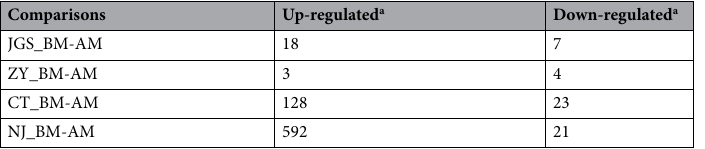
marily during the last larval instar in spongy moth, a Northern blot study detected relatively small steady-state quantities of vitellogenin RNA in adults, suggesting that completion of oogenesis initiated during the larval and pupal stages may require some small degree of vitellogenin synthesis early during the adult stage 45 . It is gener- ally accepted that female spongy moths produce 500–1000 eggs, but there are no data indicating a consistently significant difference in egg production between ASM and ESM. There has been no formal study on the appli- cability of flight-oogenesis syndrome to ASM females, but some recent research suggests that there is not always an obvious trade-off between insect migratory flight and reproduction 46 . NADH dehydrogenase subunit 1 (TRINITY_DN57574_c0_g1, TRINITY_DN50963_c0_g2), NADH dehydrogenase subunit 4 (TRINITY_DN42442_c0_g1). NADH dehydrogenase is involved in aerobic respiration and ATP synthesis 47 . Solitary locusts have higher initial flight speeds and shorter flight dis- tances than gregarious locusts, and exhibited higher mitochondrial energetic storage (Acetyl-CoA and NADH), energy metabolic gene-expression levels, and metabolic enzyme activities in their flight muscles than their gre- garious counterparts 48 . While NADH dehydrogenase subunit DEGs (for subunits 1 and 4) were found to be down-regulated in ASM, one DEG with matches to different NADH dehydrogenase subunit 1 sequences were up-regulated in ASM, suggesting either sequence divergence at this locus or two alleles with biotype-specific differences in their regulation.